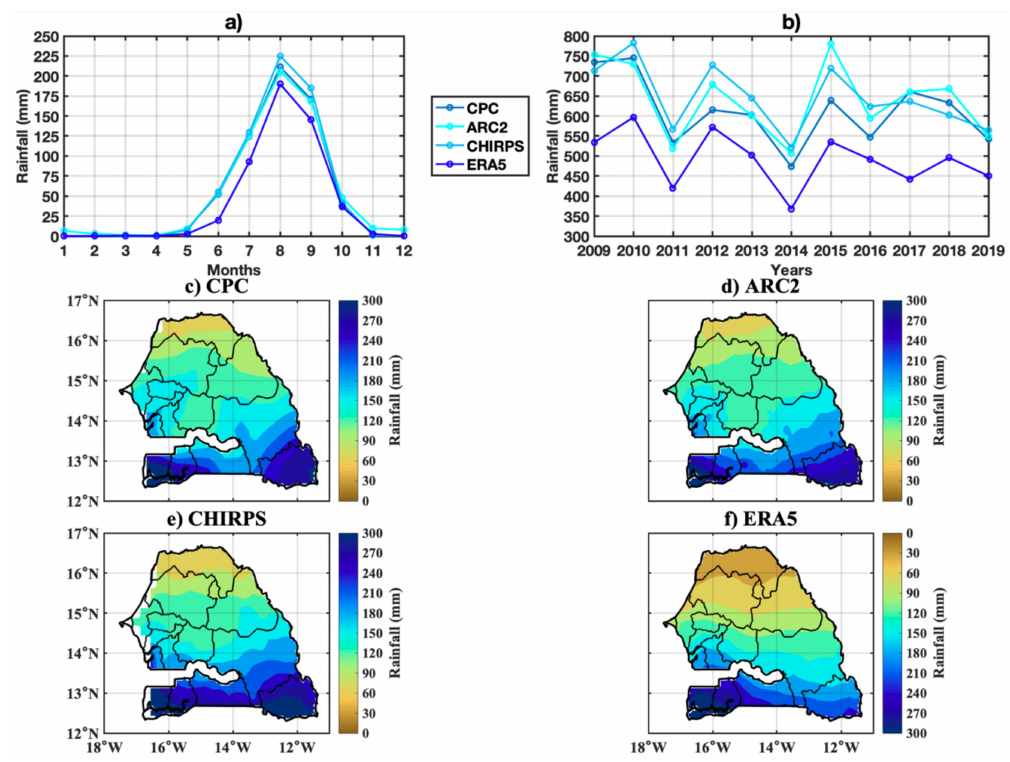
Figure 3. Spatio-temporal variability of rainfall in Senegal from 2009–2019: the annual cycle of rainfall ( a ), interannual variability of rainfall ( b ), and spatial distribution of rainfall for CPC ( c ), ARC2 ( d ), CHIRPS ( e ), and ERA5 ( f